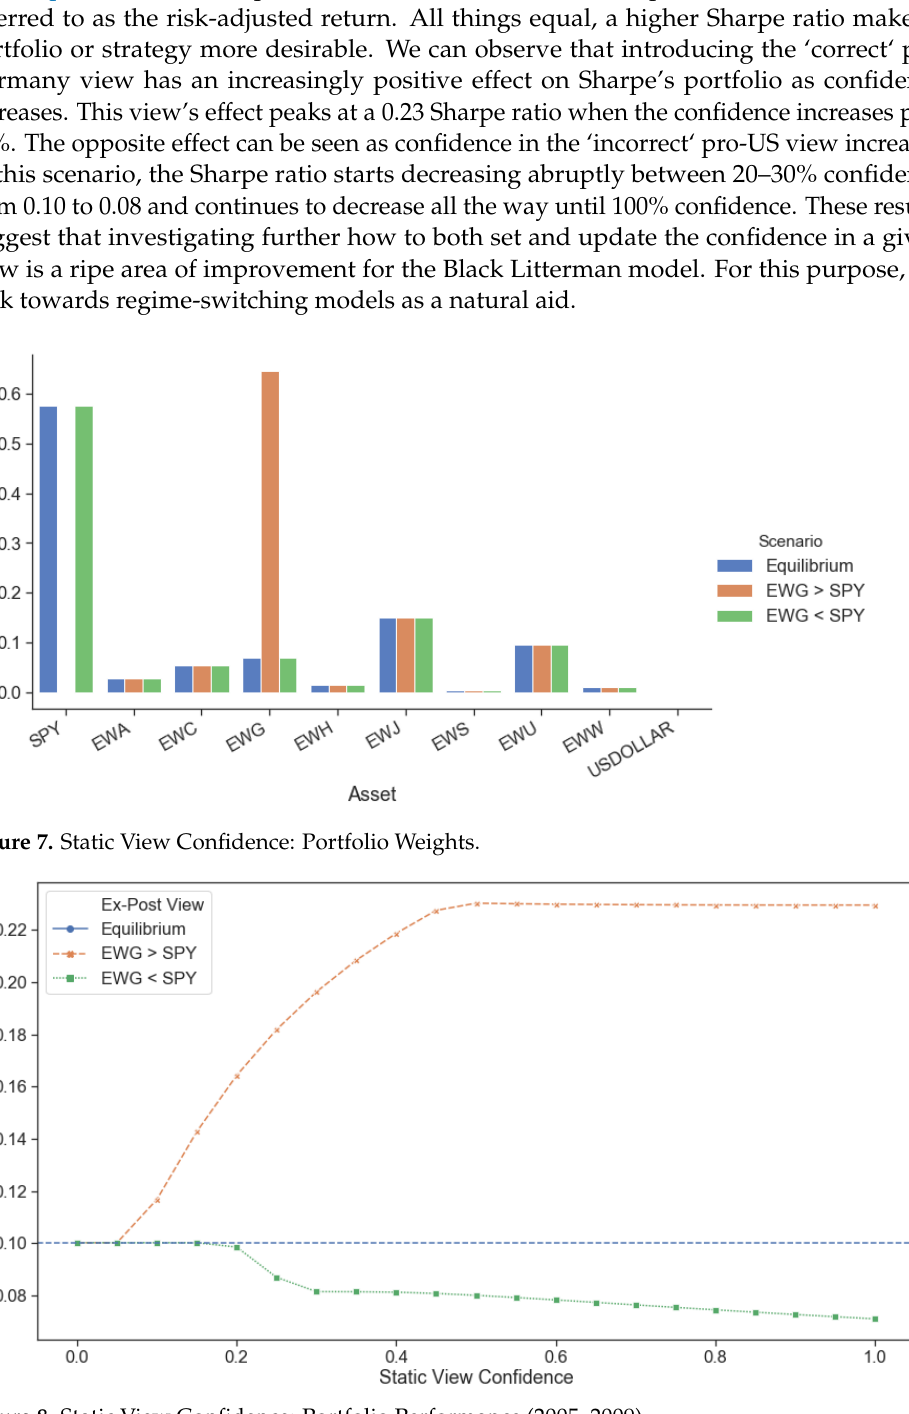
Figure 8. Static View Confidence: Portfolio Performance